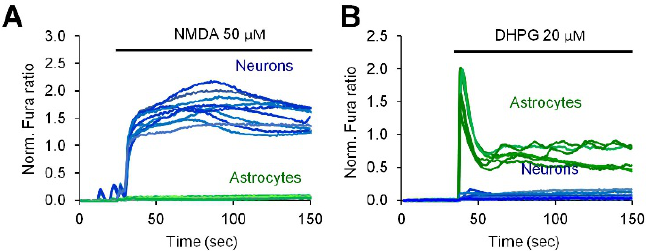
Figure 6. Cell type determination of NMDA and 3,5-Dihydroxyphenylglycine (DHPG) induced Ca 2+ responses. Hippocampal mixed neuron-astroglial cultures were stimulated with 50 µ M NMDA ( A ) or 20 µ M DHPG ( B ). Ca 2+ signals were detected using Fura-2 single cells imaging in astrocytes (green traces) and in neurons (blue traces).